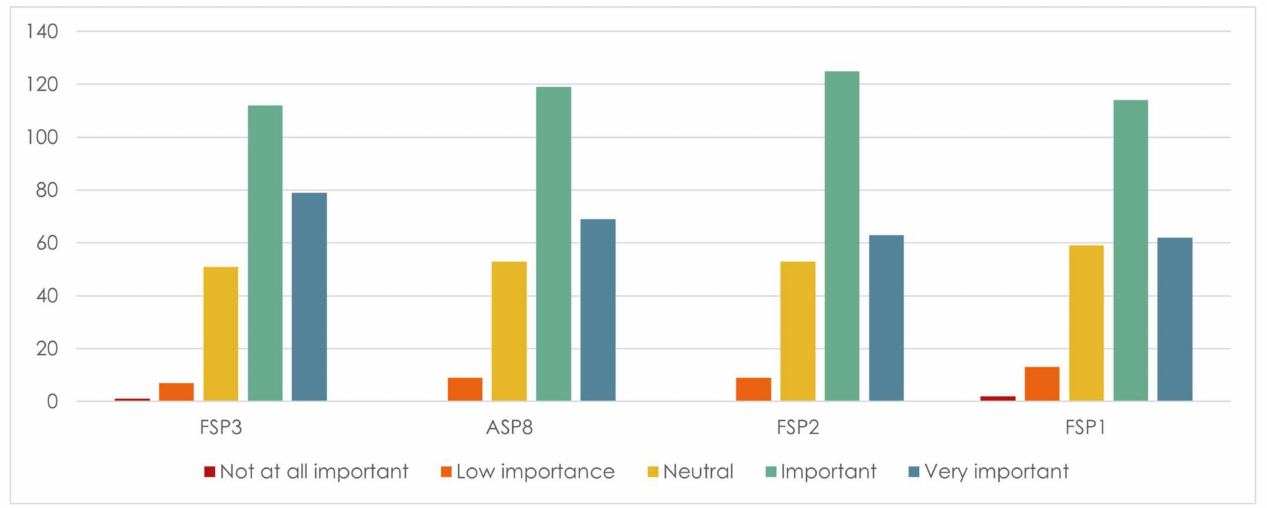
Figure 6. Perceived importance of reducing environmental load